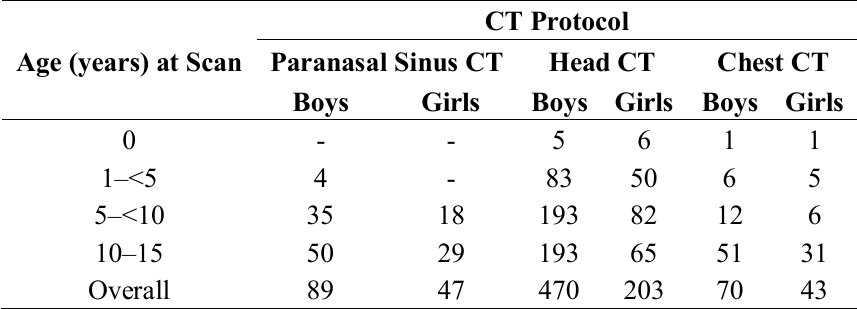
Table 2. Demographics of the children in this cohort.